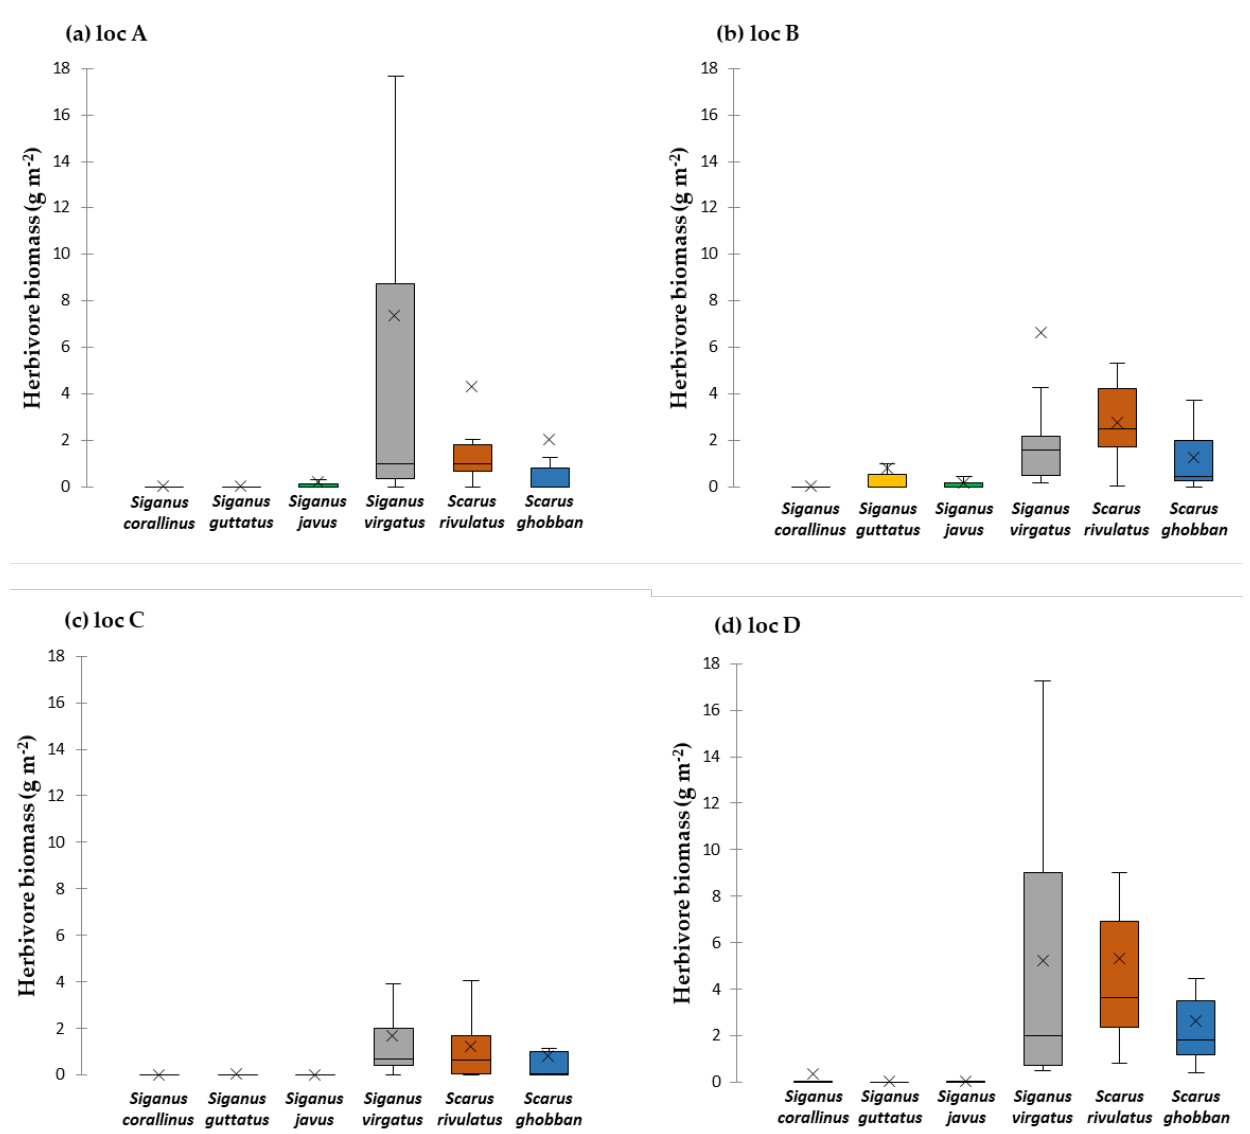
(Table 2). Benthic data for sites A – D on the reef crest in 2018 was within a similar range as in 2015 for the fished reef (Table S7).